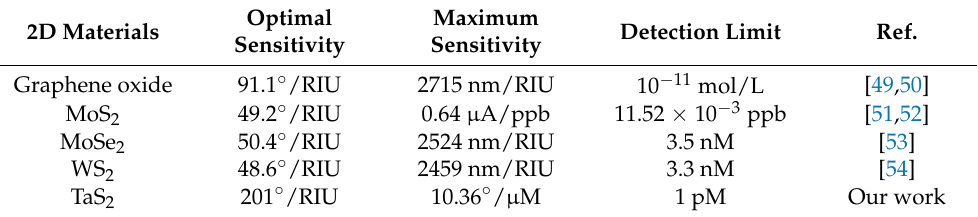
Table 1. Different 2D material sensing medium layers to improve